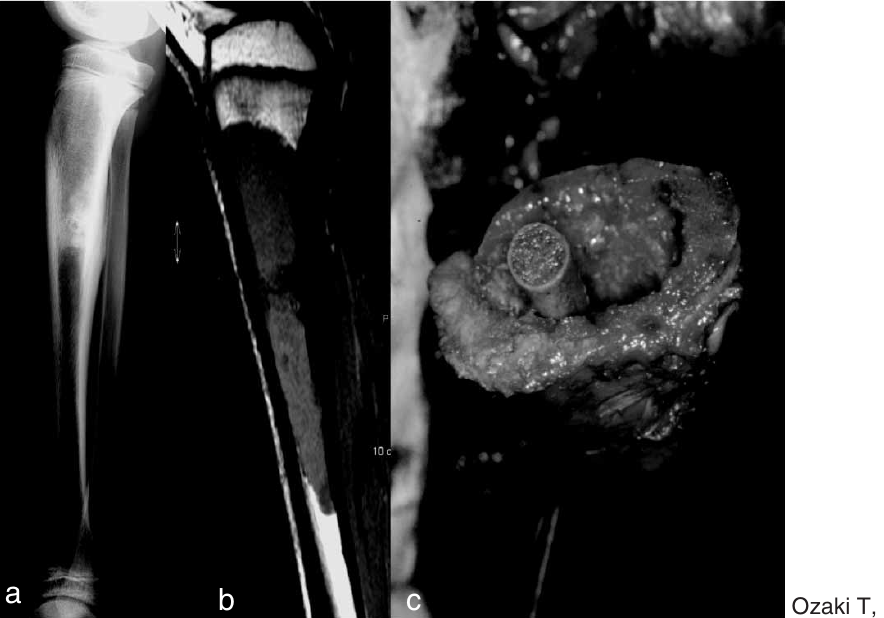
Fig. 4. Case 2 . (a) Radiograph showed periosteal reaction of the posterior proximal meta-diaphysis of the tibia and sclerotic shadow in the proximal meta-diaphysis of the right tibia. (b) Magnetic resonance images showed a low signal intensity area (T1-weighted images). (c) The fibula end protrudes from the pasteurized